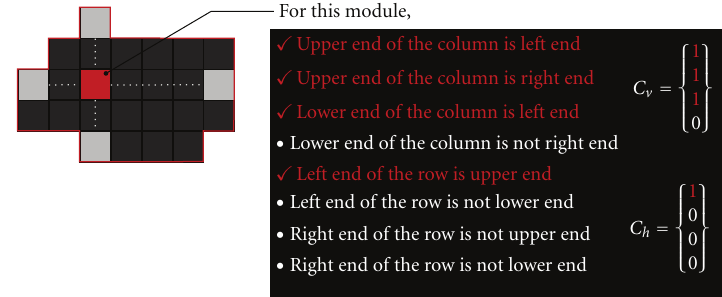
Figure 6: An example of concerned local shapes about a module.